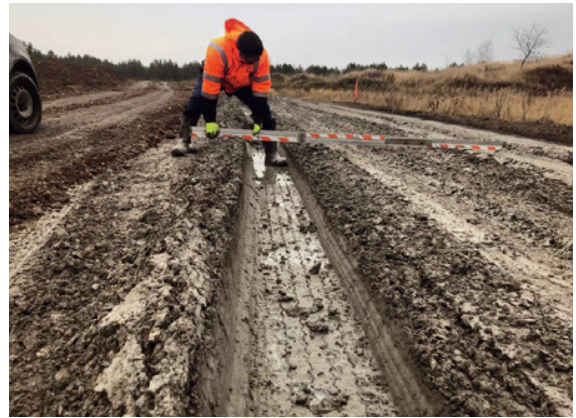
Figure 9. Full-scale test section No.